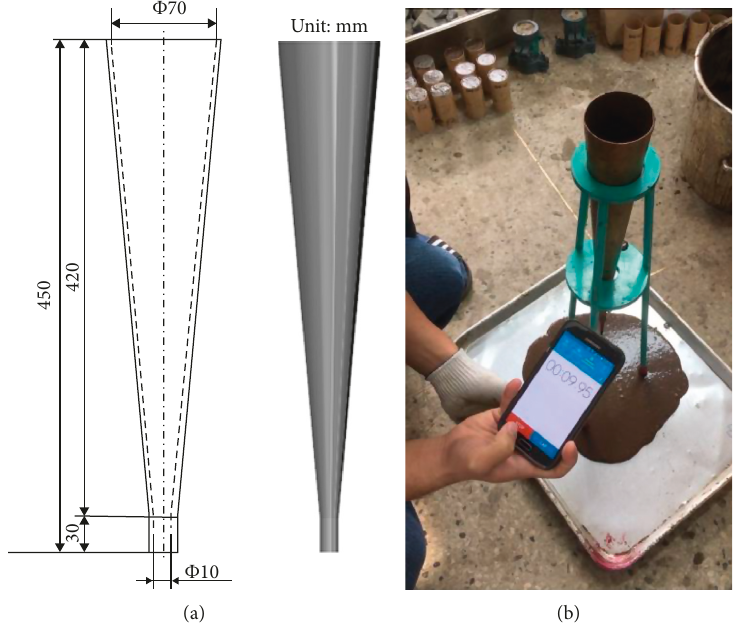
Figure 2: Flow cone funnel test (a) and flowability test (b).